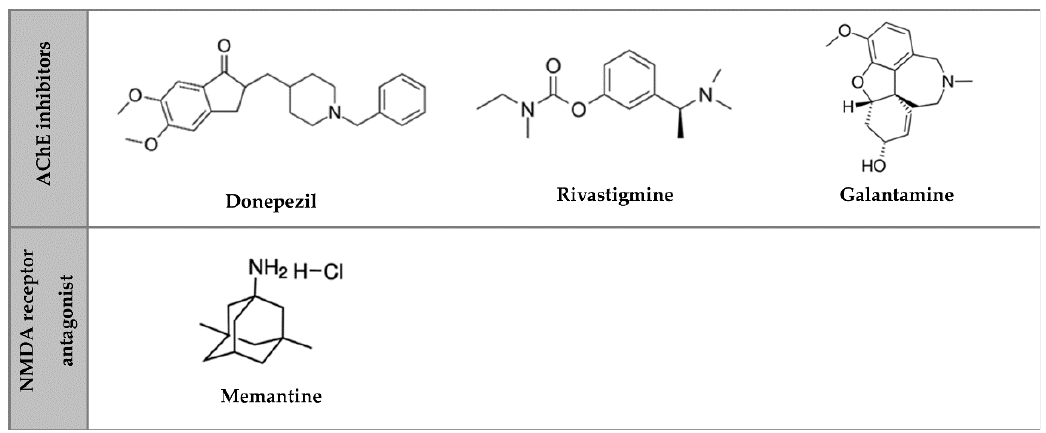
Figure 1. Chemical structure of AD drugs. AChE is an enzyme that degrades acetylcholine, a neurotransmitter involved in synapses. AChE inhibitors block AChE, causing acetylcholine accumulation,